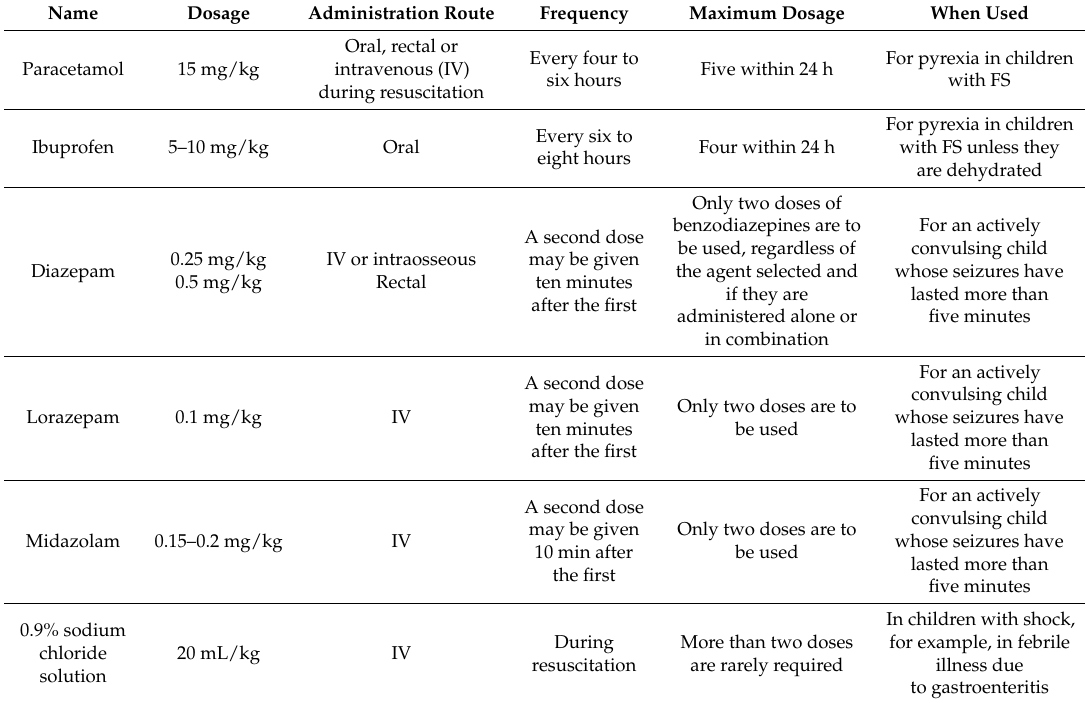
Table 4. Drugs commonly used for children with febrile seizures (FS) who present to the Emergency